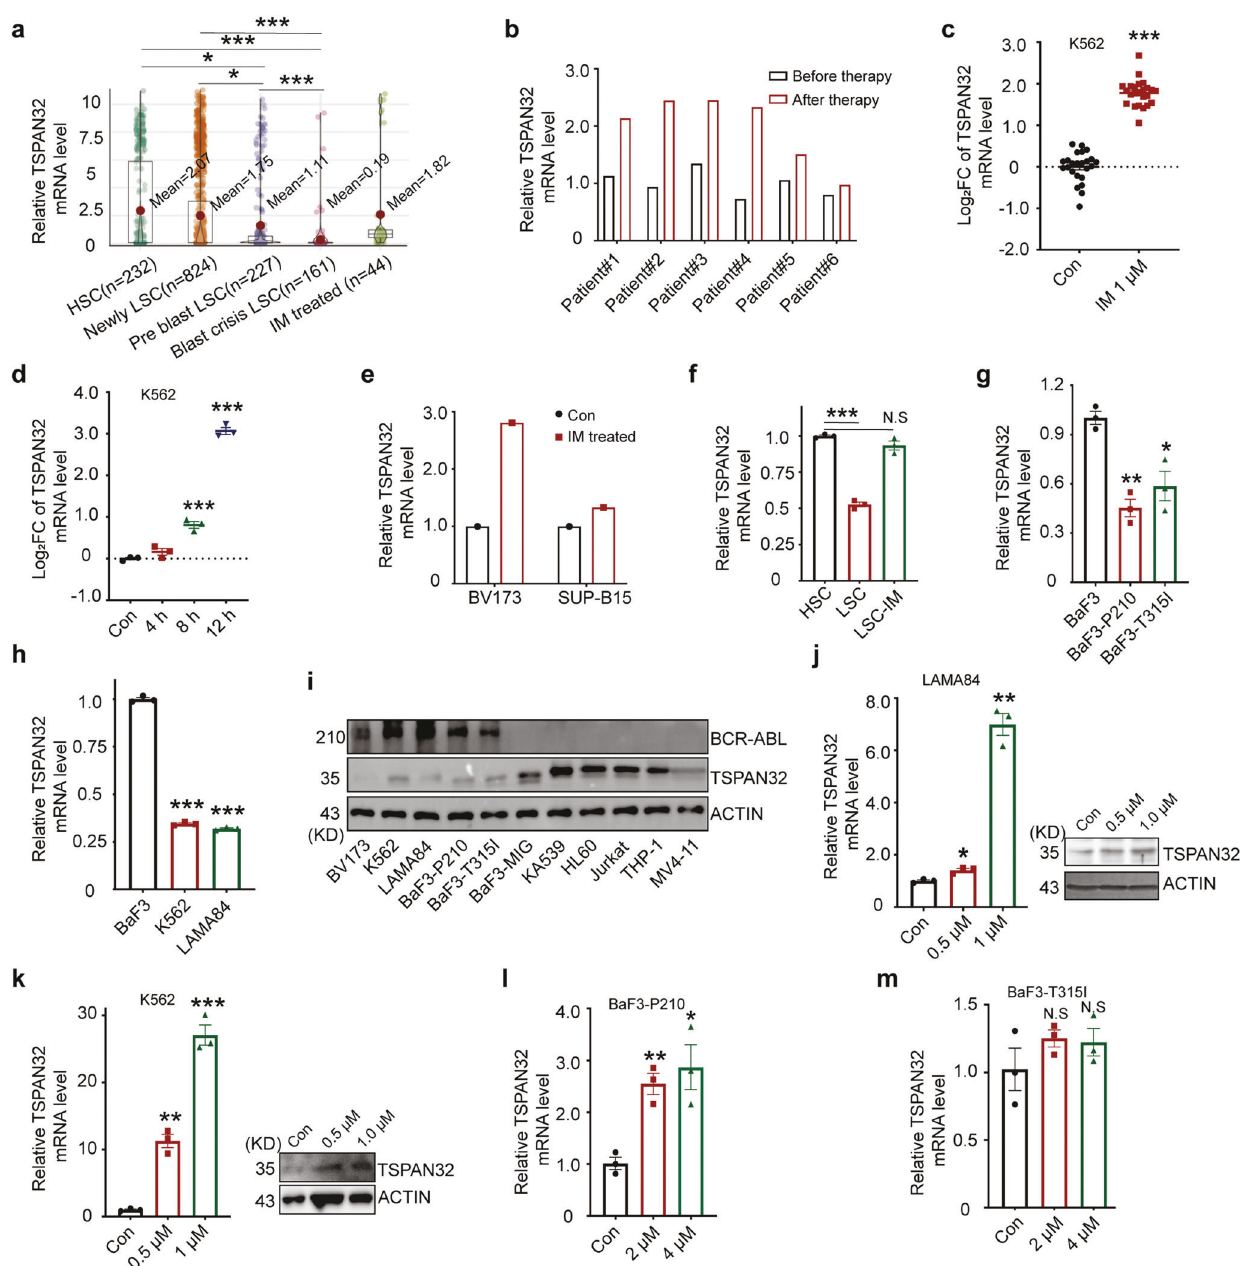
Fig. 1 BCR-ABL decreases TSPAN32 expression. a The GSE76312 scRNA-seq data for TPSAN32 in CD34 + cells from healthy donors, BCR-ABL + CD34 + cells from different stages of CML patients, and CML patients treated with Imatinib (Healthy HSC, n = 232; Newly LSC, n = 824; Pre blast LSC, n = 227; Blast crisis LSC, n = 161; Imatinib treated, n = 44). b GSE12211 microarray data for TSPAN32 expression in CD34 + cells from patients with chronic stage CML that received Imatinib. c GSE1922 microarray data for TSPAN32 in K562 cells treated with 1 μ M Imatinib for 24 h. d GSE51083 microarray data for TSPAN32 in K562 cells treated with 100nM Dasatinib for 4, 8 and 12h. e An analysis of expression changes in microarray data (GES7182) for Ph + B-ALL cell lines, which received 10 μ M Imatinib for 16h. f Tspan32 mRNA was examined with RT-PCR in HSCs isolated from healthy C57/B6J mice, and LSCs were isolated from BCR-ABL induced CML recipients treated with or without Imatinib ( n = 3, each group). g BaF3 cells transfected with BCR-ABL or BCR-ABL(T315I), RT-PCR analysis for Tspan32 mRNA, BaF3 cells were used as the control. h RT-PCR analysis of TSPAN32 mRNA levels in BaF3, K562 and LAMA84 cells. i Protein levels of TSPAN32 in Ph + cell lines (BV173, K562 and LAMA84), BaF3 cells transfected with BCR-ABL (P210 or T315I) or empty vector (MIG), and other hematologic malignancy cell lines without BCR- ABL fusion gene (KA539, HL60, Jurkat, THP-1, and MV4-11) were detected with immunoblotting. The expression statuses of BCR-ABL were also examined and shown. ACTIN served as sample loading control. j , k LAMA84 and K562 cells were treated with the indicated concentration of Imatinib for 24h, the TSPAN32 protein and mRNA changes were analyzed with immunoblotting and RT-PCR, respectively. l , m BaF3 cells transfected with BCR-ABL or BCR- ABL(T315I) were treated with Imatinib at the indicated concentration for 24 h, and Tspan32 mRNA was analyzed using RT-PCR. Error bars denote mean ± SEM, * P < 0.05, ** P < 0.01, *** P <0.001 ( T -test)